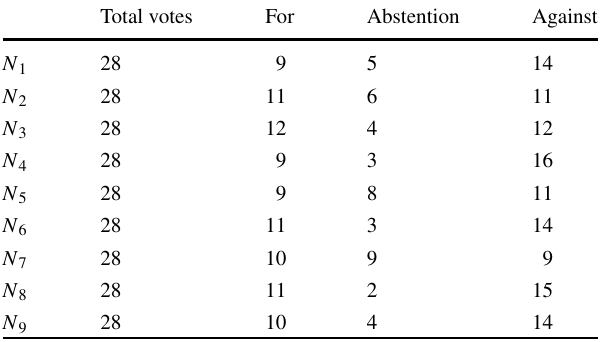
Table 10 Classical voting results for nine nodes Total votes